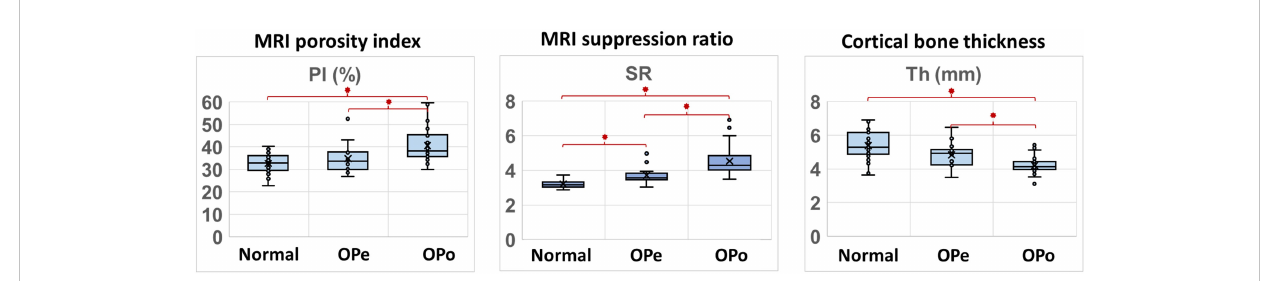
FIGURE 2 Boxplots of PI, SR, and bone thickness in the Normal, OPe, and OPo groups. Average, median, SD, and fi rst and third quartile values are indicated in the